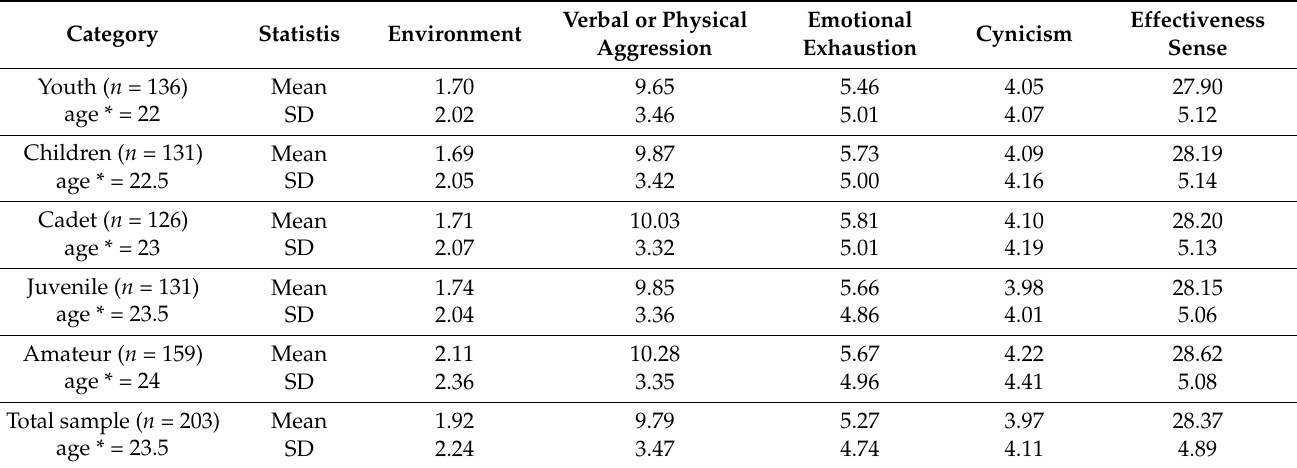
Table 5. Descriptive statistics of each factor according to the category